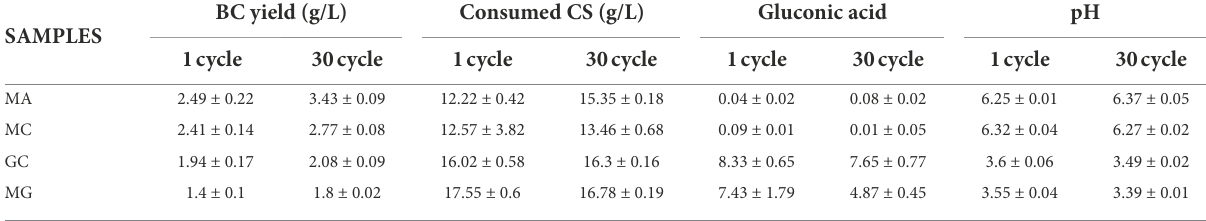
TABLE 1 Comparison between 1 and 30 cycles in term of BC produced, consumed carbon source, gluconic acid, and pH.